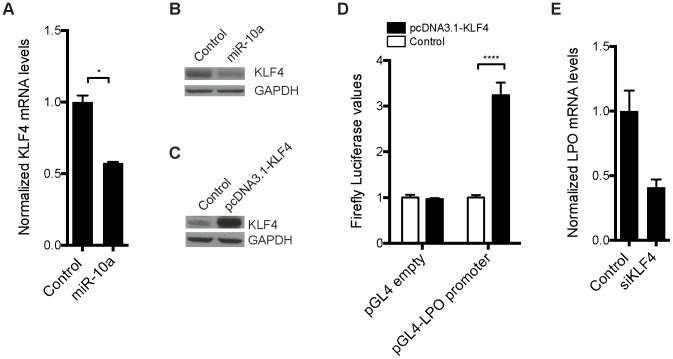
Transcription factor KLF4 is regulated by miR-10a and can regulate the LPO promoter in vitro.HCT-116 cells were transfected with a miR-10a duplex or control for 72 h. (A) Relative mRNA levels of KLF4 were measured by qRT-PCR and ACTB was used for normalization. Data are shown as mean ± S.D. of three replicates relative to the control and are representative of three independent experiments. * p<0.05 using a two-tailed t-test. (B) Protein levels in miR-10a or control transfected cells were assessed by Western-blot using antibodies against KLF4. GAPDH was used as loading control. (C) Western Blot showing the over expression from the pcDNA3.1-KLF4 vector. GAPDH was used as loading control. (D) Luciferase reporter assay in HCT-116 cells (24 h) with pGL4-luc2 holding part of the LPO promoter (1 kb upstream TSS) or the pGL4-luc2 empty vector co-transfected with a vector over-expressing KLF4 or a control vector (pcDNA3.1+). Data are shown as mean ± S.D. of three replicates relative to the pcDNA3.1 transfected control and are representative of eleven independent experiments. **** p<0.0001 using a two-tailed t-test. (E) HCT-116 cells were transfected with KLF4 siRNA for 48 h or 72 h. Relative mRNA levels of LPO were measured by qRT-PCR and ACTB was used for normalization. Data are shown as mean ± S.D. of three replicates relative to the control and are representative of five independent experiments.